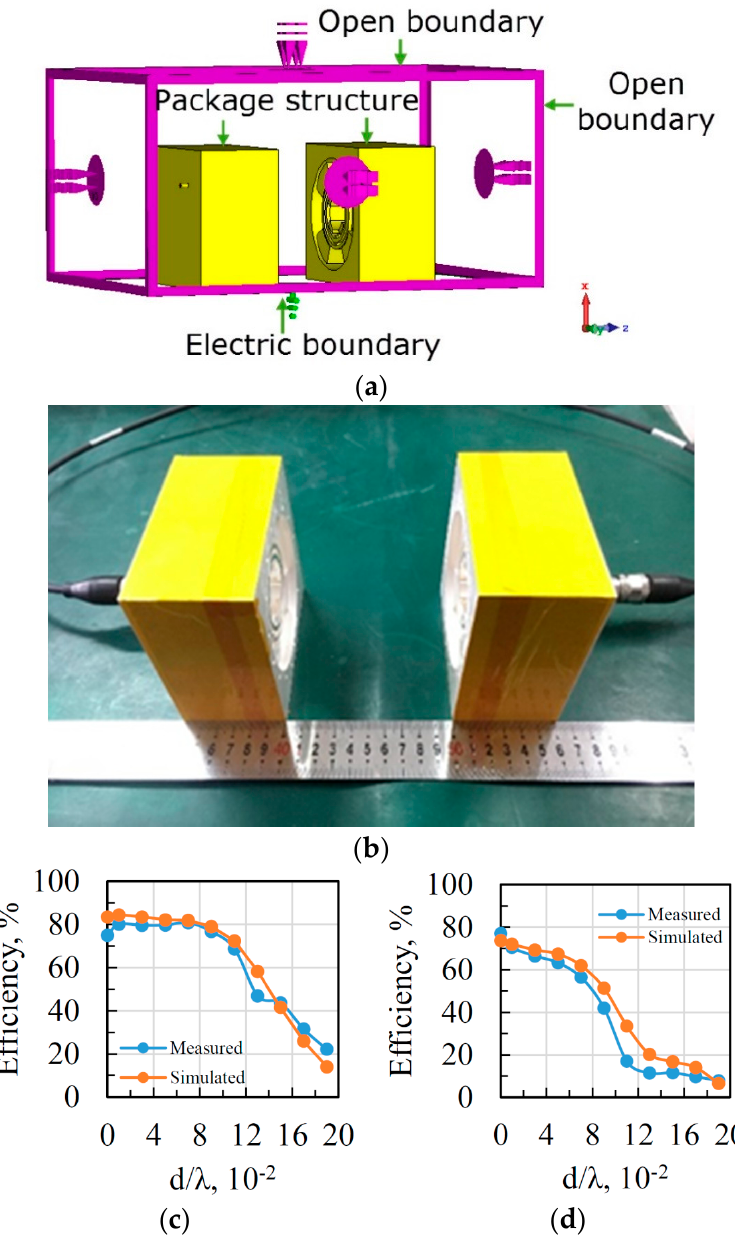
Figure 7. Experimental setup and results: ( a ) Simulation model, ( b ) experimental setup, ( c ) WPT efficiency for the π mode, and ( d ) WPT efficiency for the π + 1 mode.